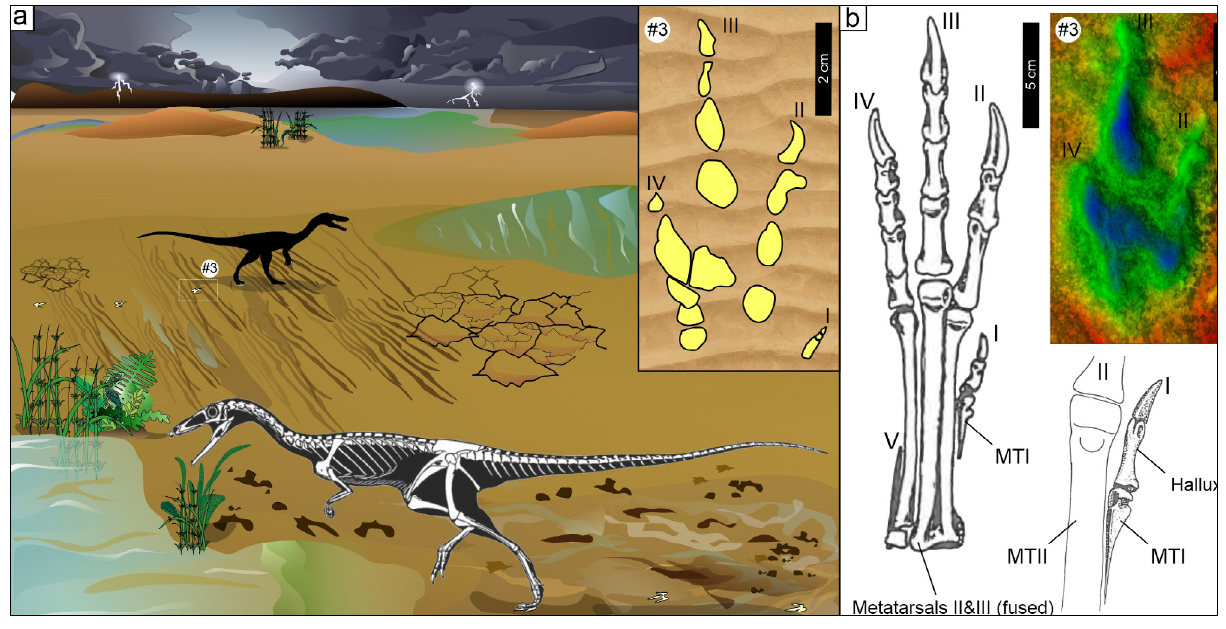
Figure 7: Interpretation of the Grallator trackway in the lower Clarens Formation at the Storm Shelter ichnosite. (a) Palaeoenvironmental reconstruction (modified from original artwork by Akhil Rampersadh and Emese M. Bordy). Dinosaur outlines are adapted from Paul 47 (foreground) and Rampersadh et al. 36 (background). Inset shows the interpretative outline of track #3. (b) Skeletal reconstructions of the left foot and hallux of Megapnosaurus rhodesiensis are adopted from Raath 43 (his figure 20) . Inset shows the relative position of the hallux trace in this left footprint of the Grallator trackmaker (false-colour depth map of track